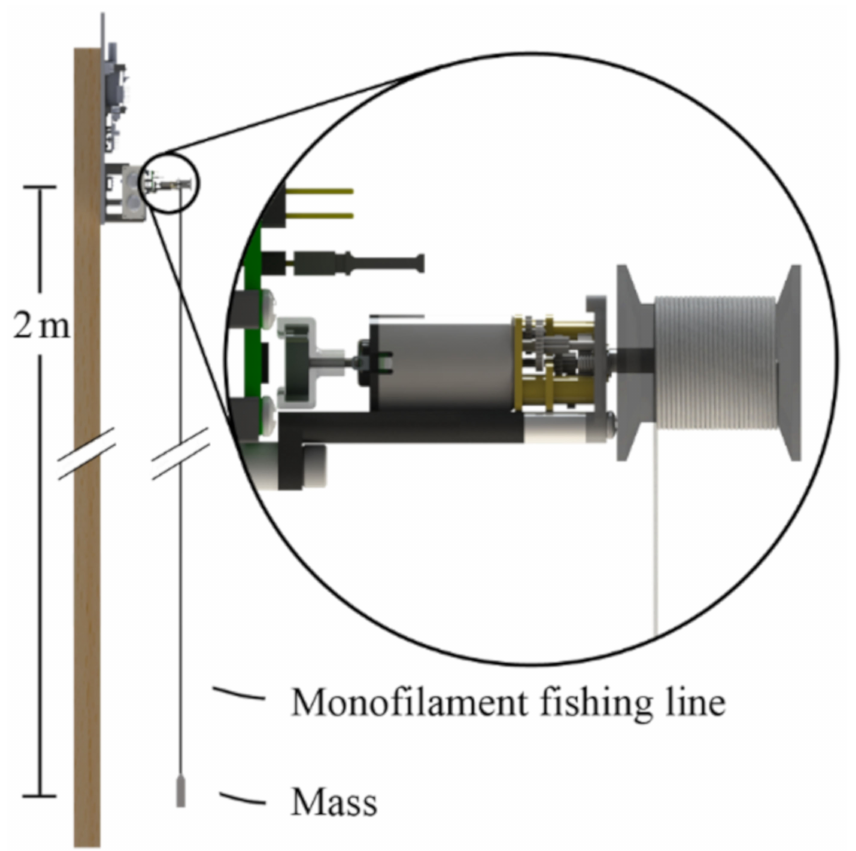
Figure A2. Depiction of motor load calibration experiment. Care was taken to ensure that the cord does not spool, thus preventing the radius from changing and maintaining a constant torque applied to the motor throughout the